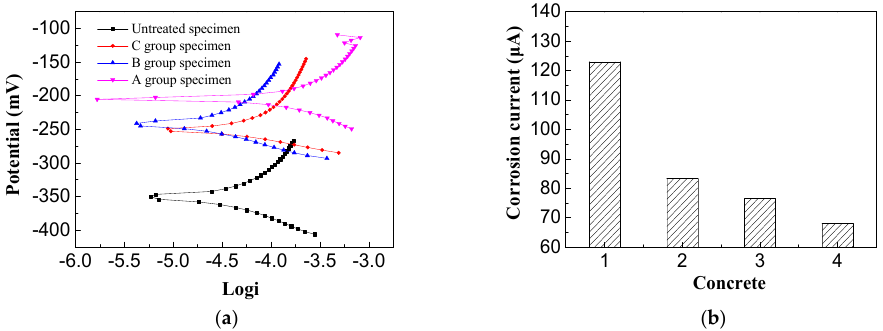
Figure 10. Corrosion potential and current of steel bar. ( a ) Corrosion potential; ( b ) Corrosion current.